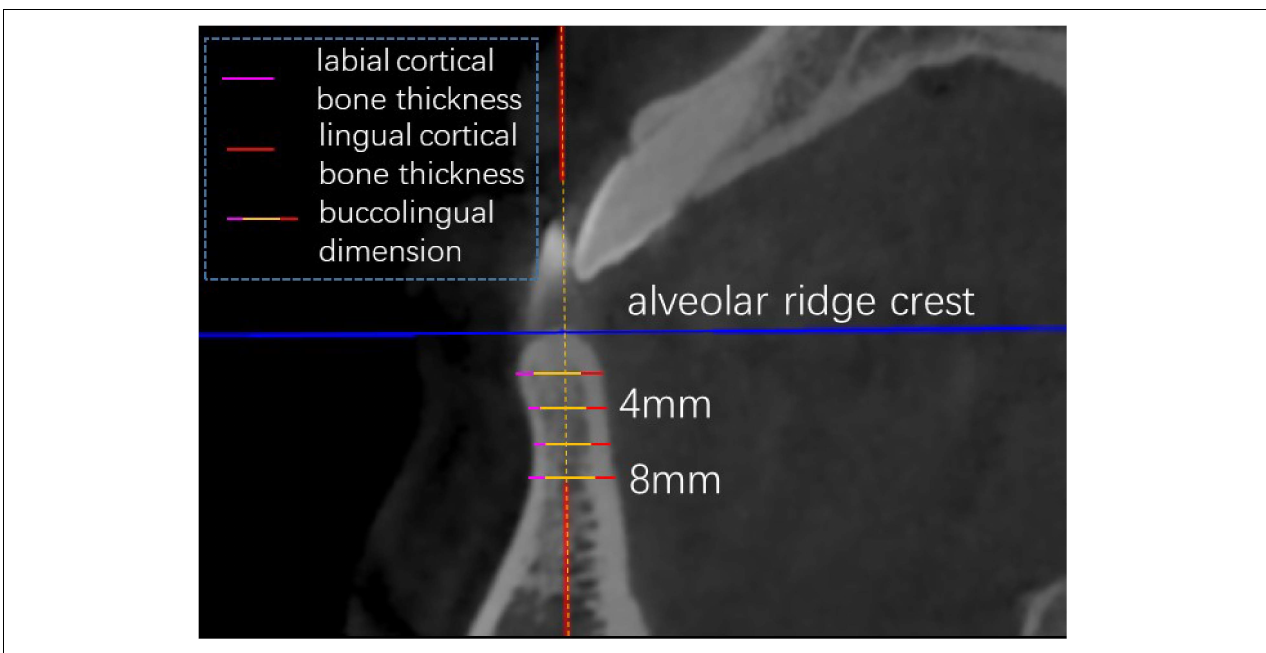
FIGURE 3 | CBCT measurement: buccolingual dimension, labial cortical bone thickness and lingual cortical bone thickness in sagittal view.